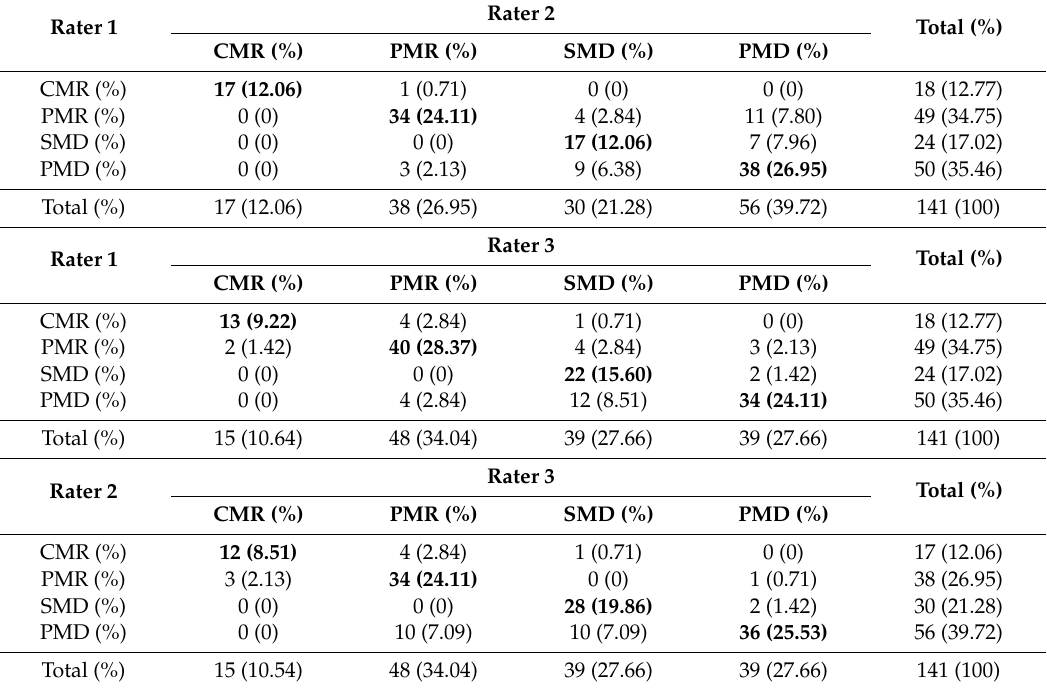
Table 3. Interrater response assessment using